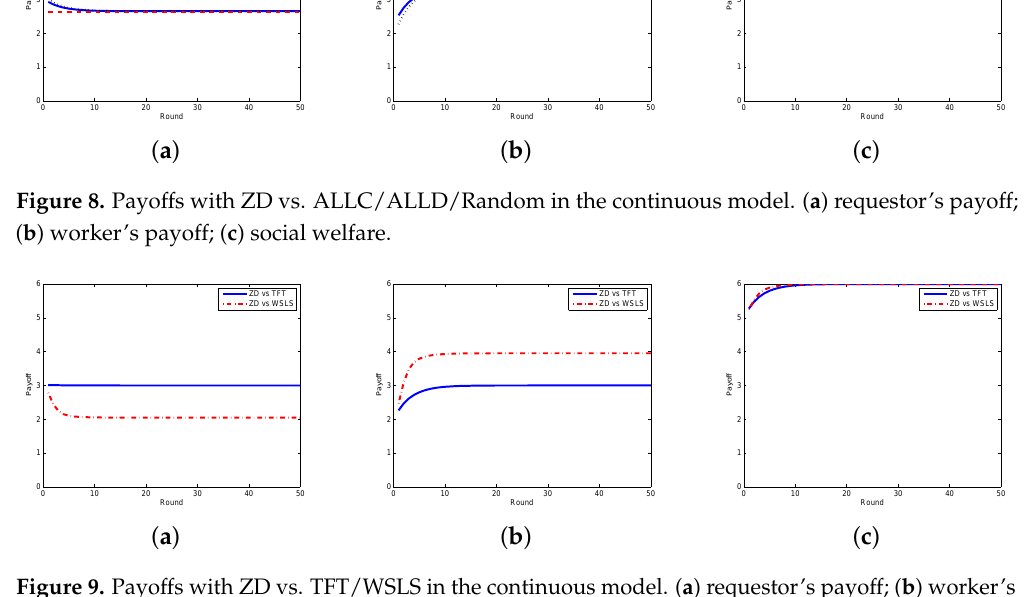
Figure 9. Payoffs with ZD vs. TFT/WSLS in the continuous model. ( a ) requestor’s payoff; ( b ) worker’s payoff; ( c ) social